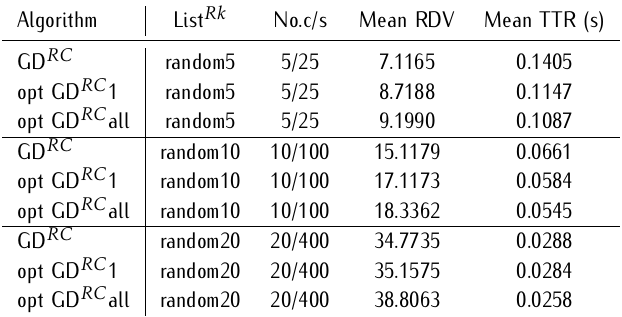
Table 8. Asynchronous CRs with asymmetric channel views: Average (Mean) number of potential RDVs per cycle and average TTR (seconds) for optimized RAC 2 E-gQS with optimized slot allocation (a) for the best channel only (opt GD RC 1) (b) for all channels (opt GD RC all) in comparison with GD RC from Section 4; No.c/s stands for Number of channels / slots; List Rk is the channel ranking lists